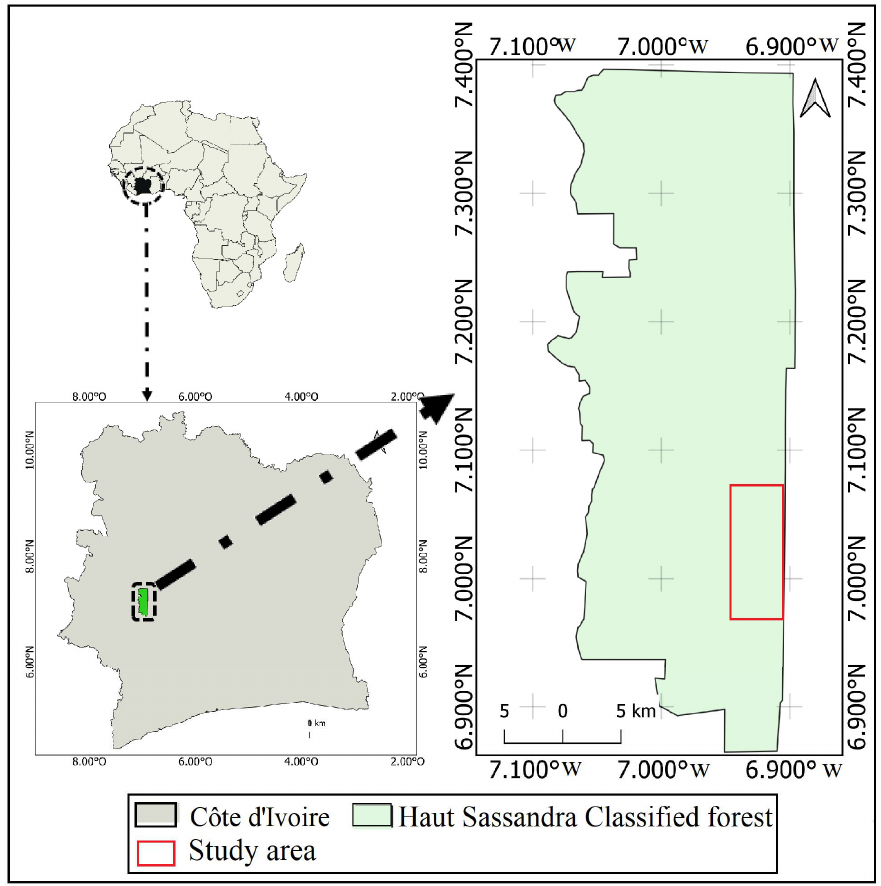
Figure 1. Locations of the Haut-Sassandra classified forest in C ô te d’Ivoire, and the sampling